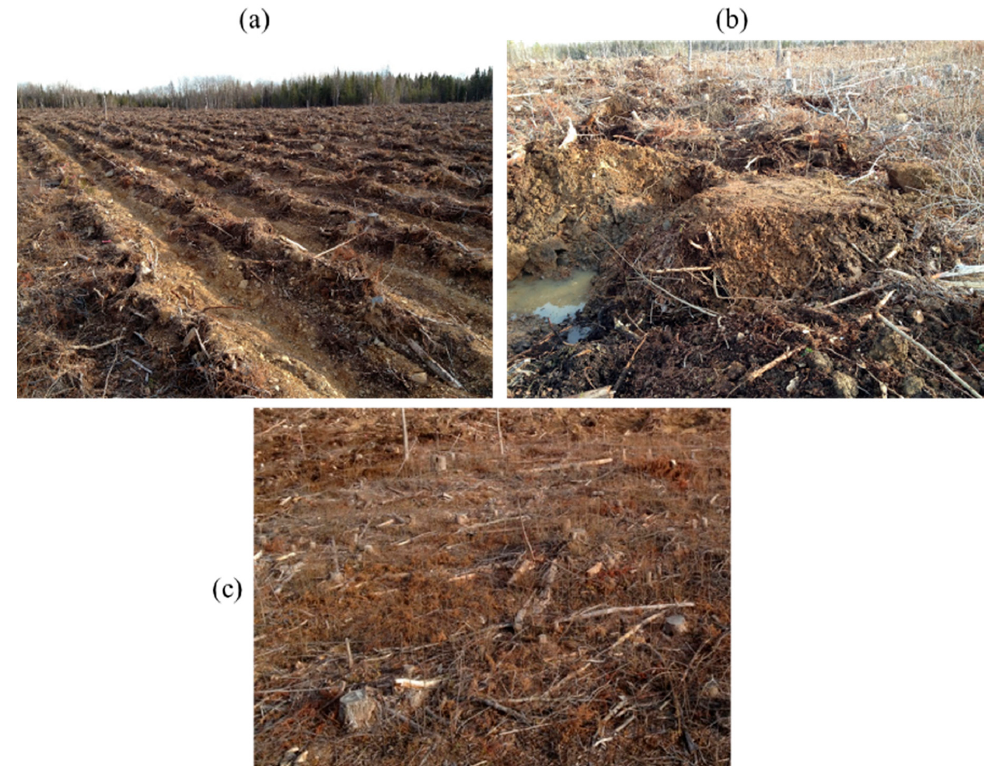
Figure 1. Example of main plots with the site preparation treatments that were tested in the study. The “V-blade” treatment resulted in 2.7 m wide × 0.47 m deep furrows that exposed the mineral soil ( a ). Mounding site preparation consisted in 0.3 m high × 1.5 m wide × 1.5 m long inverted mounds adjacent to the holes